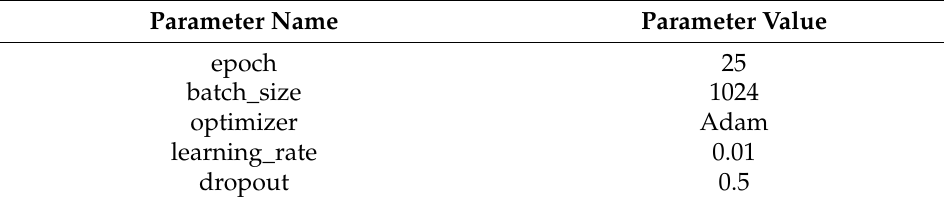
Table 3. Parameter name and corresponding value.